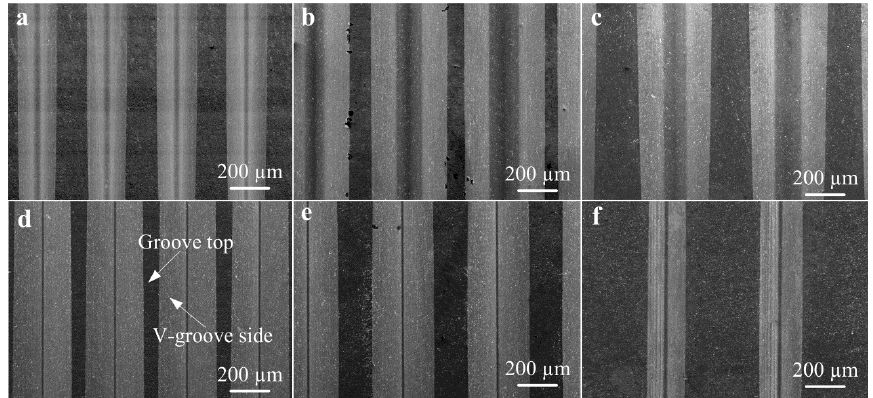
Figure 6. SEM photos of micro-ground mold cores: (a) Sample A m ; (b) Sample B m ; (c) Sample C m ; (d) Sample D m ; (e) Sample E m ; (f) Sample F m .